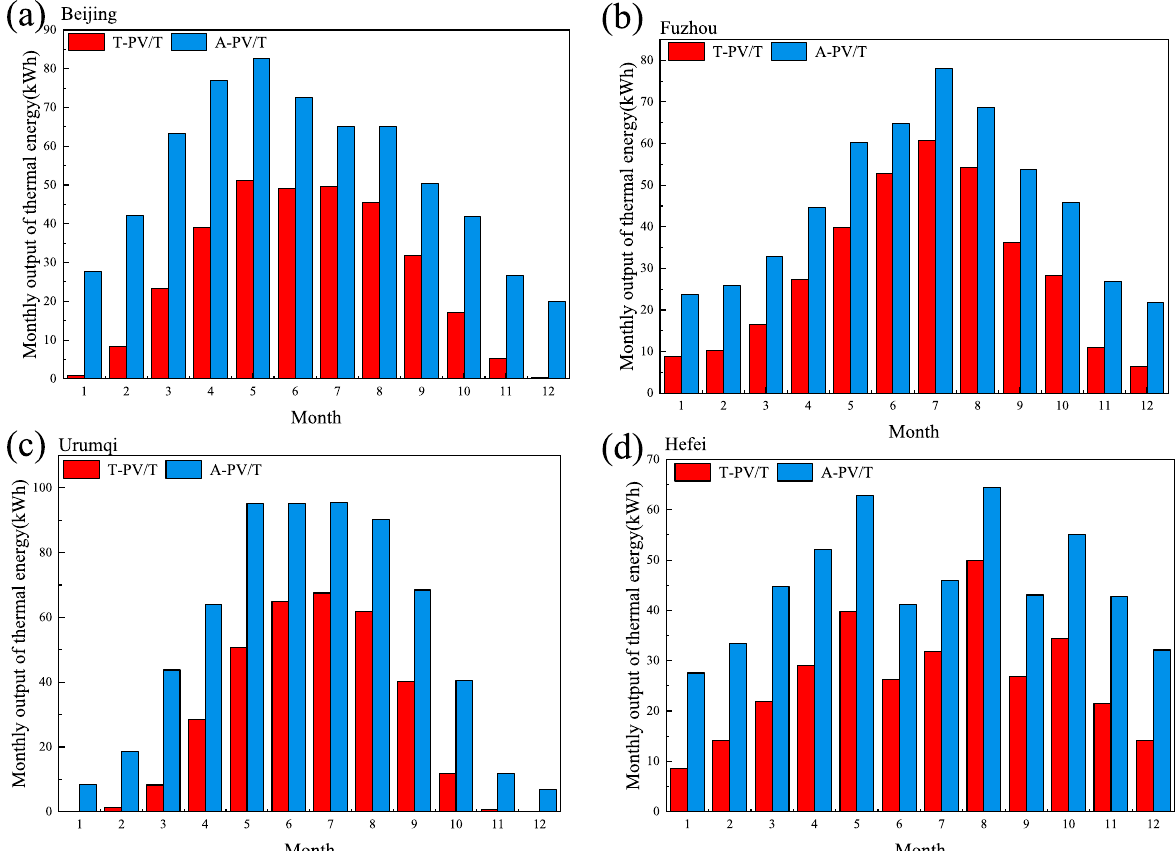
Fig. 14 Monthly output of thermal energy in a Beijing, b Fuzhou, c Urumqi, and d